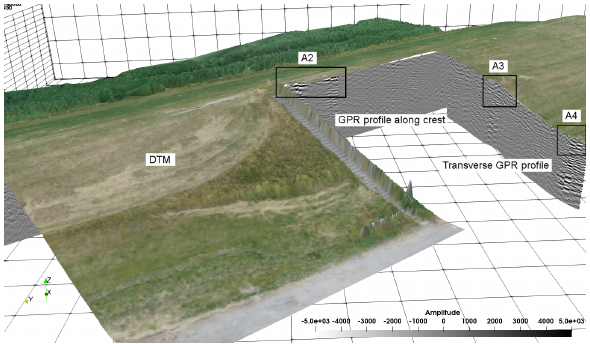
Figure 8. Combined DTM and GPR profiles on section